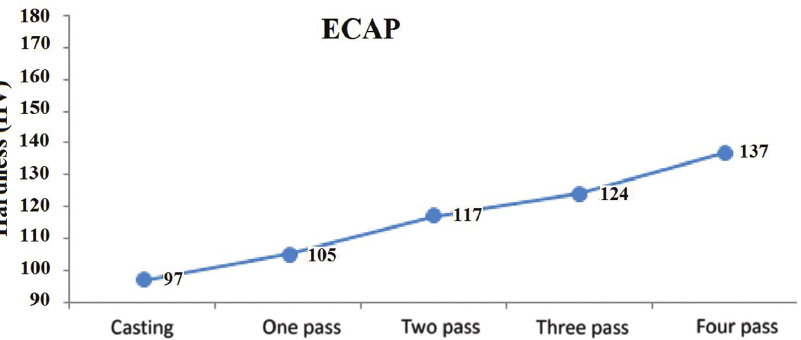
Figure 5: Vickers hardness of ECAPed and casting AA7075 samples.